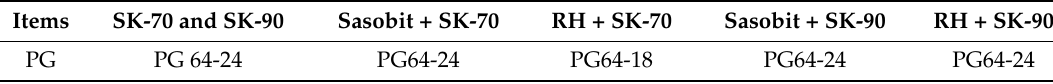
Table 1. PG Classifications of Organic Additive-Modified Asphalts.